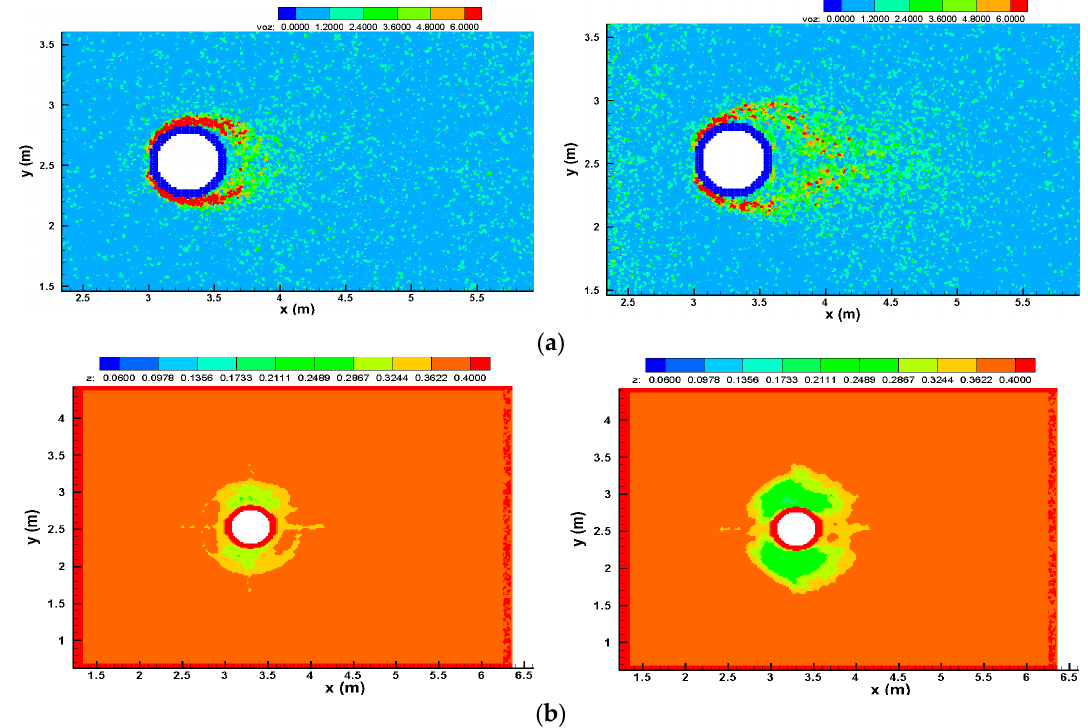
Figure 3. ISPH computed sediment bed scouring process: ( a ) snapshots of ISPH calculated vorticity in the scouring pit; ( b ) Snapshots of the ISPH calculated scouring pit.